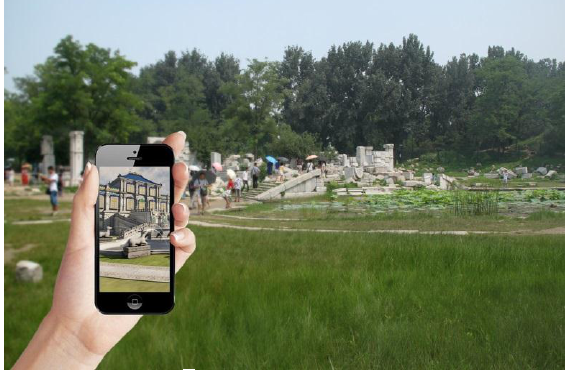
Figure 8. digital exhibition with